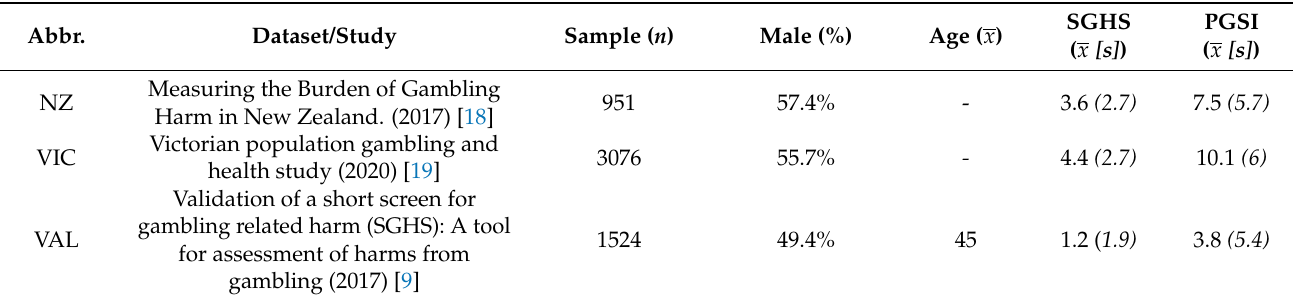
Table 1. Datasets and average scores on the Short Gambling Harm Screen (SGHS) and Problem Gambling Severity Index (PGSI).